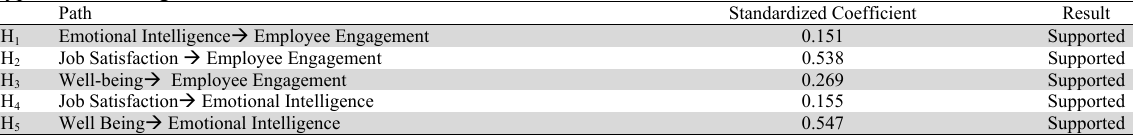
Hypothesis Testing